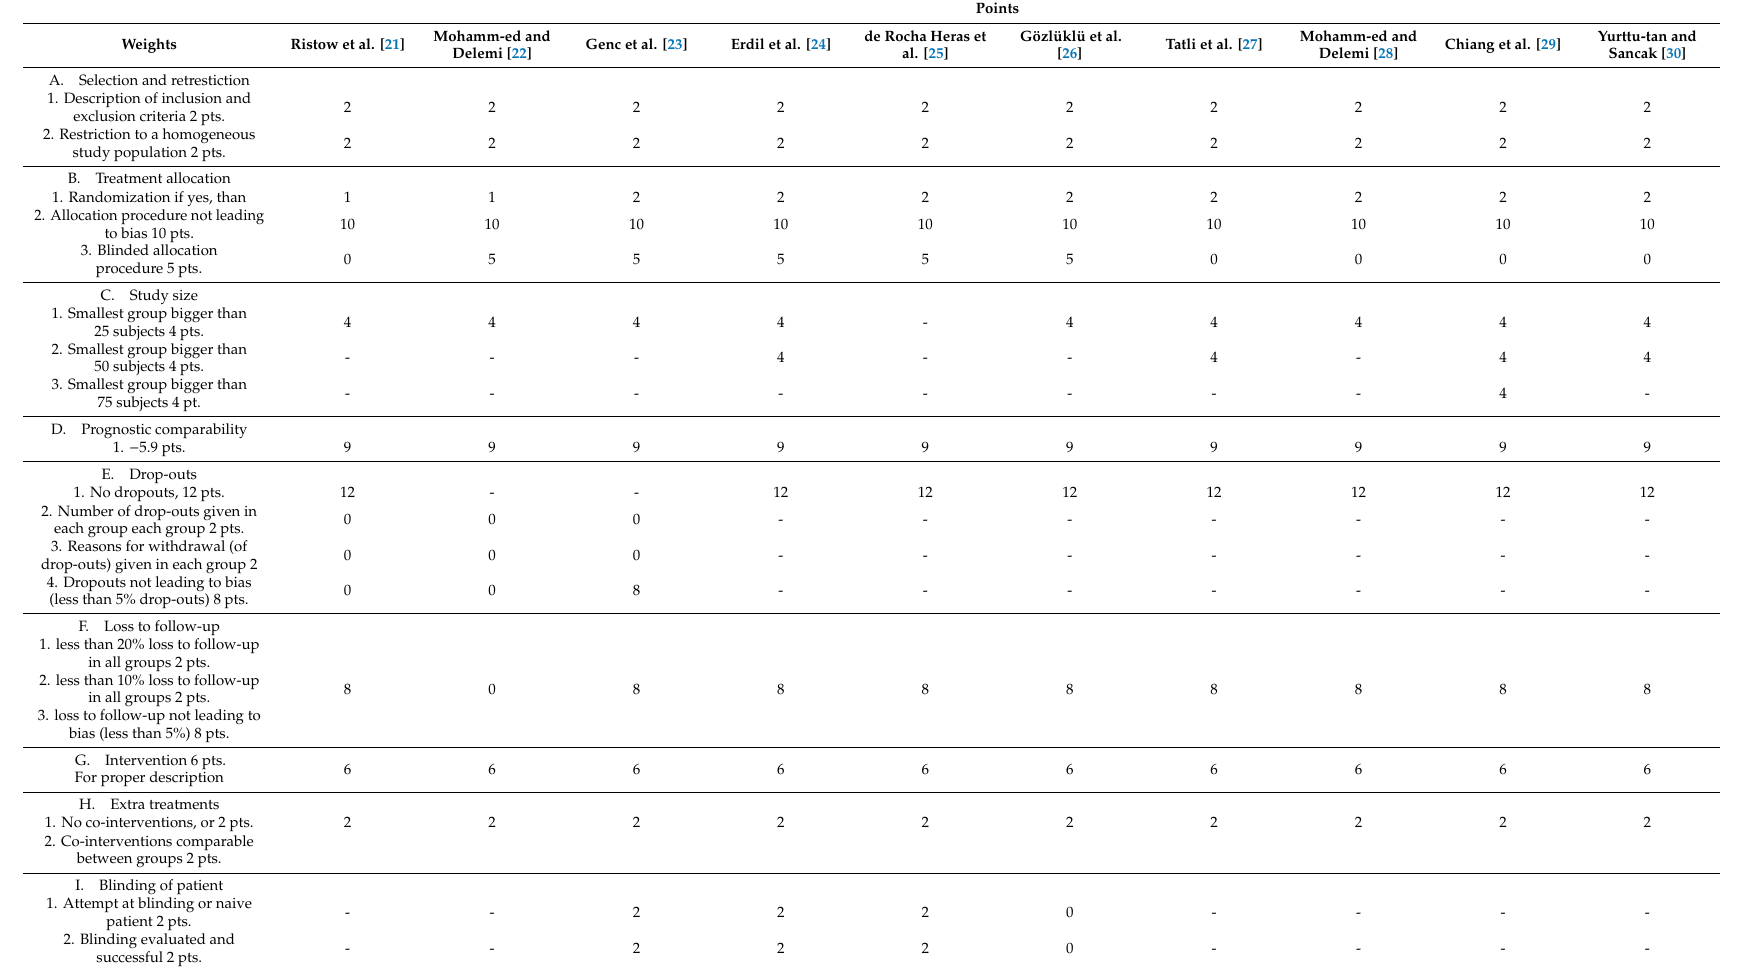
Table 3. Quality assessment according to the Maastricht